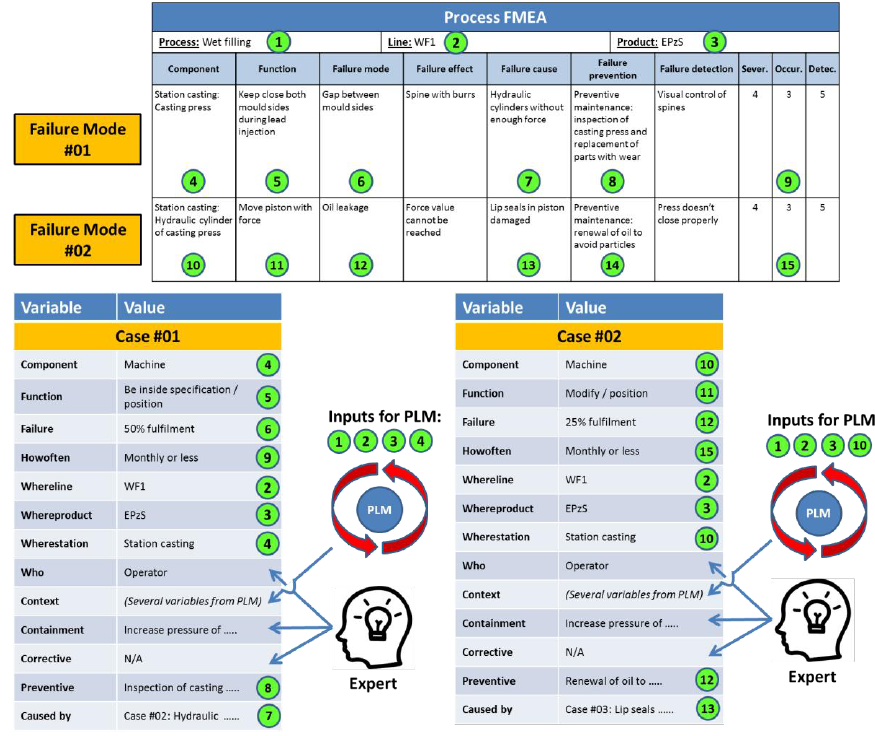
Figure 4. Information match between PFMEA and the knowledge model.